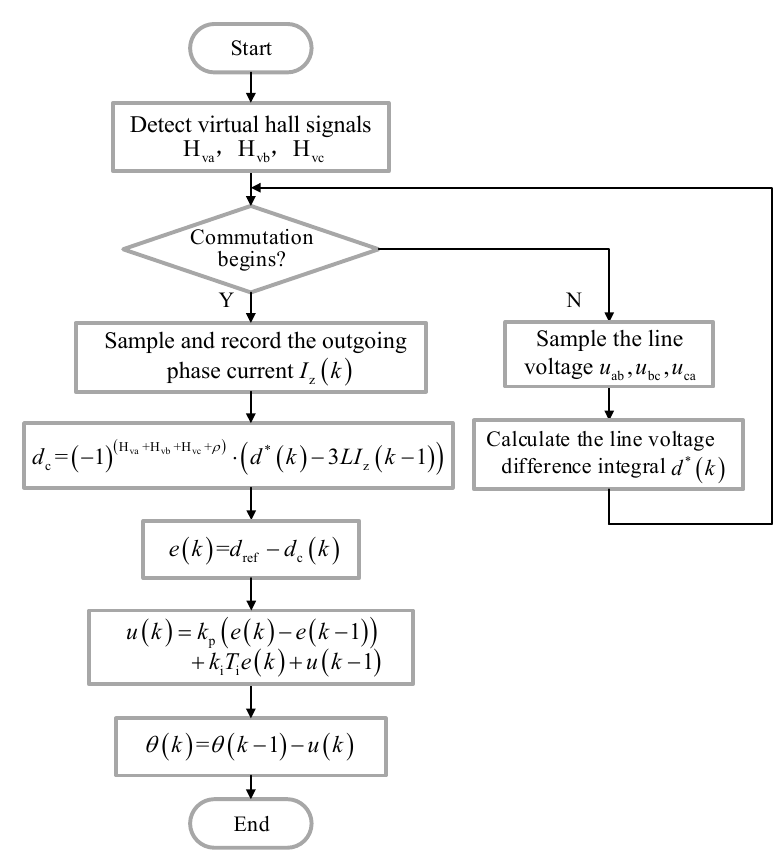
Figure 9. Flowchart of the commutation error compensation procedure.